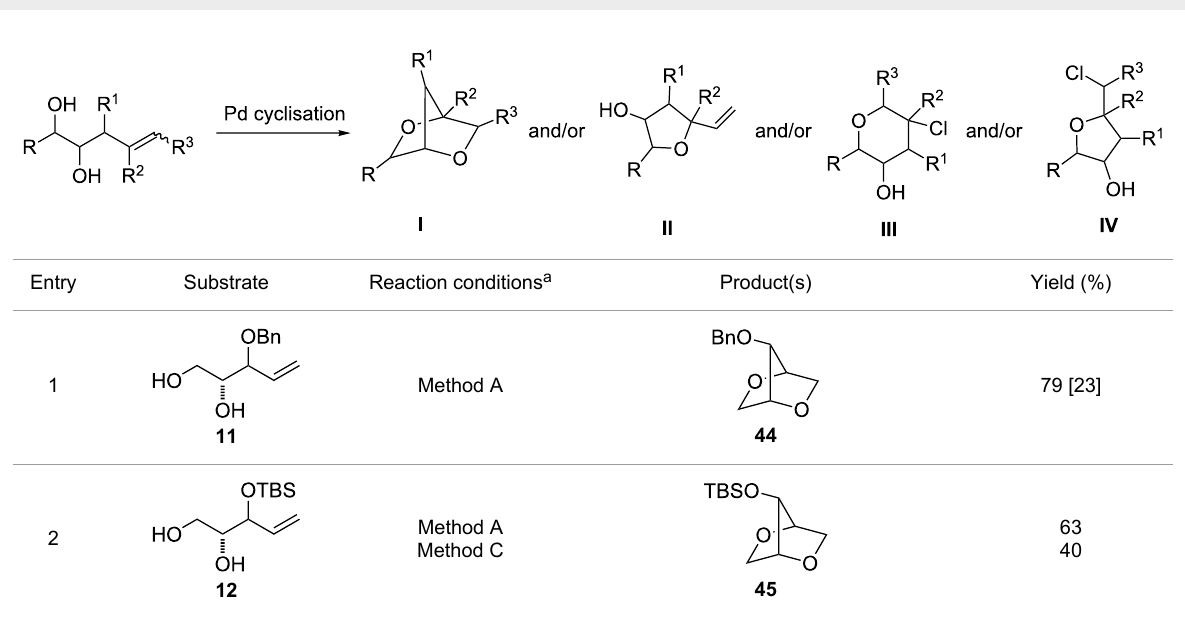
Table 1: Pd-Catalysed cyclisations of unsaturated polyols.